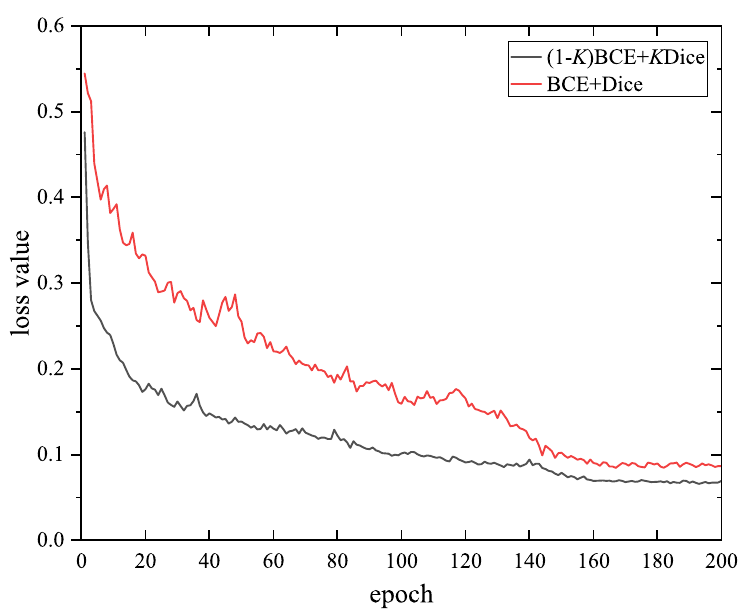
Figure 7. Progression of loss values in the training process. K is set to 0.2 in this comparison